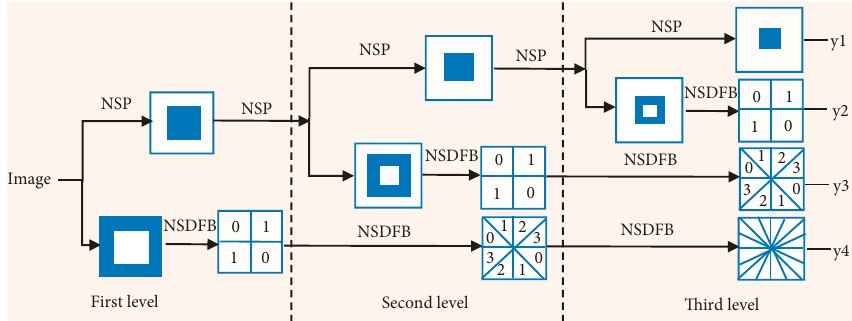
Figure 4: NSCT decomposition block